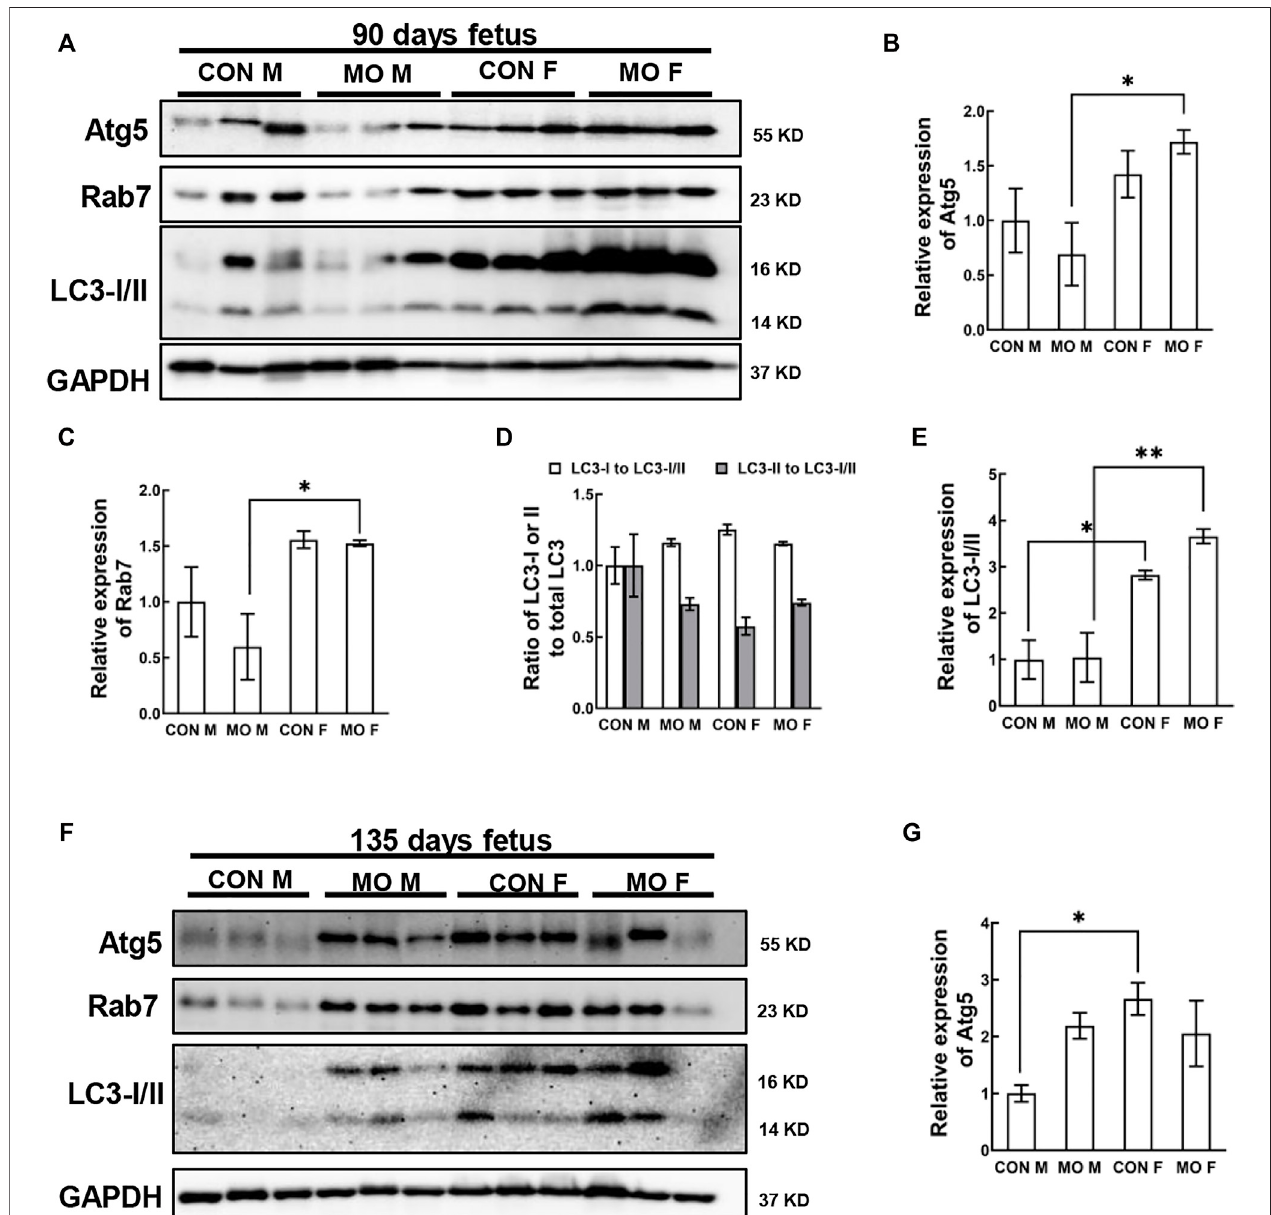
FIGURE 3 | Alteration of autophagy signaling pathway in offspring heart of overfed ewes at two gestational and one early postnatal time point. (A – E) . Relative expression andphosphorylationlevelofhallmarkproteinsinfetalheartatmid-gestationday90; (F – J) .Relativeexpression andphosphorylation levelofhallmarkproteins in fetal heart at late-gestation day 135; (K – O) . Relative expression and phosphorylation level of hallmark proteins in neonatal heart at day 1 after birth; GAPDH, Protein loading control. CON, control, MO, maternal obesity, M, male, and F, female. Mean ± SEM ( n (cid:1) 5); * p < 0.05, ** p < 0.01.